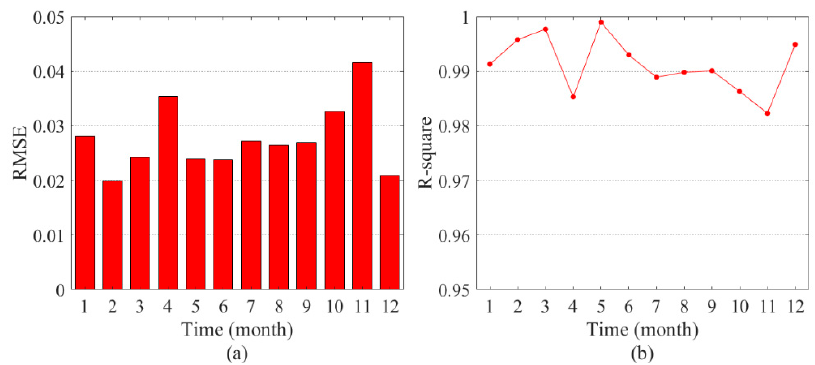
Figure 4. The (a) root mean square error (RMSE) and (b) R-square of the least-squares fitting results di ff erent of different months.